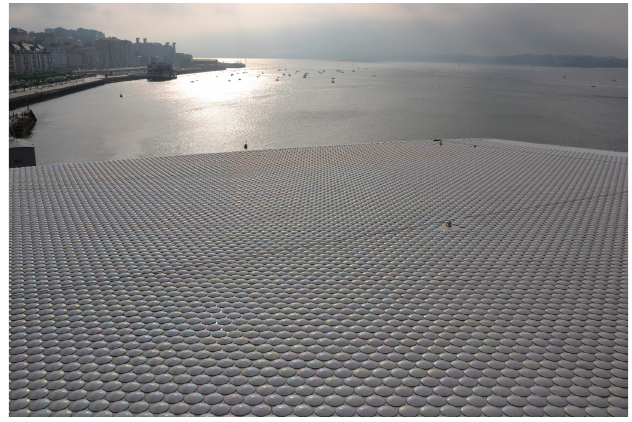
Figure 4. View from the roof. Chromatic integration with the sea. Photograph: Fernando Echarri. Appl. Sci. 2019 , 9 , x